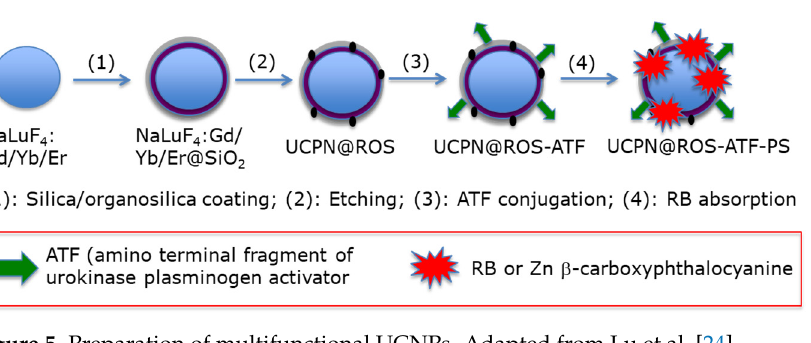
Figure 5. Preparation of multifunctional UCNPs. Adapted from Lu et al. [24].